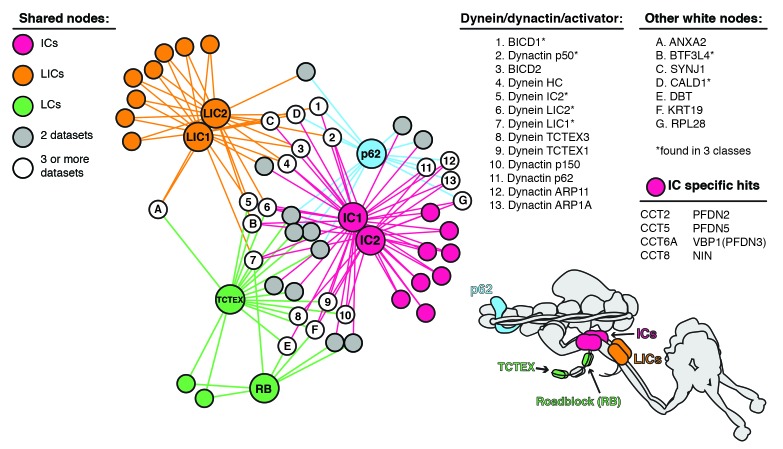
Enriched and significant hits from dynein and dynactin BioID datasets were used to construct a protein-protein interaction network.Large spheres represent BioID-tagged subunits (color coded according to a schematic of the dynein/dynactin complex, bottom right). Hits (small spheres) specific to a subunit family, color-coded according to their respective subunits: LCs (green), ICs (magenta) and LICs (orange). Gray spheres (‘two datasets’) and white spheres (‘three or more datasets’) represent hits enriched in two or three separate datasets, respectively. The protein names corresponding to white spheres are listed, right. Dynein and dynactin subunits, and activators are numbered; other hits are indicated with letters. Asterisk denotes hits detected in three different subunit classes (e.g. LICs/ICs/p62). Lines connecting spheres (edges) are color coded according to their respective datasets. For this figure enrichment is ≥3 fold, significance is p<0.05, Student’s two-tailed t-test; and average spectral counts are ≥2.